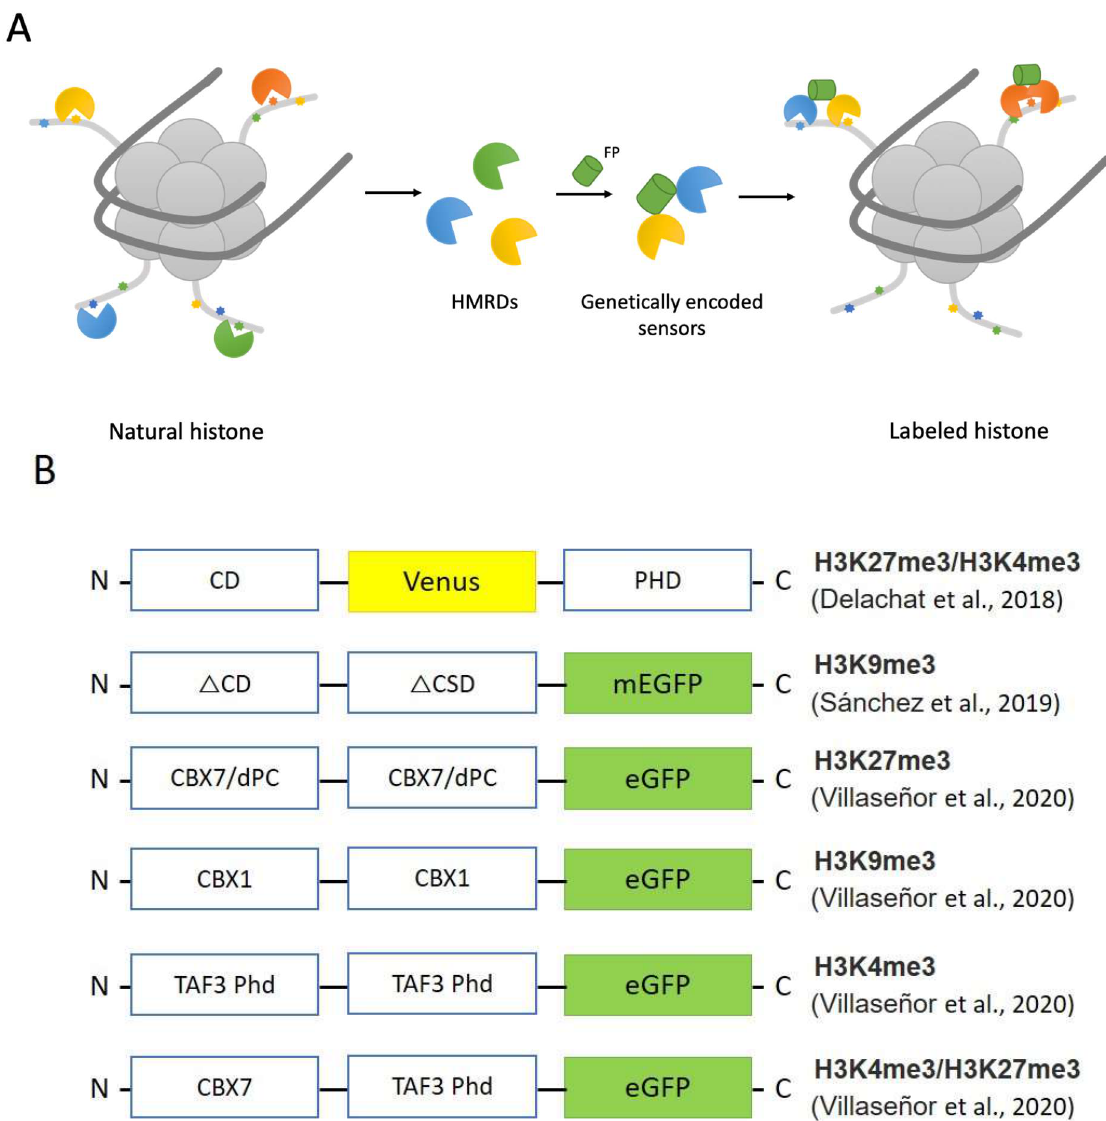
Figure 5. Reader domain-based sensors for live-cell imaging. ( A ) General design of reader domain- based sensors. ( B ) Domain structures of reporters described below [79–81].